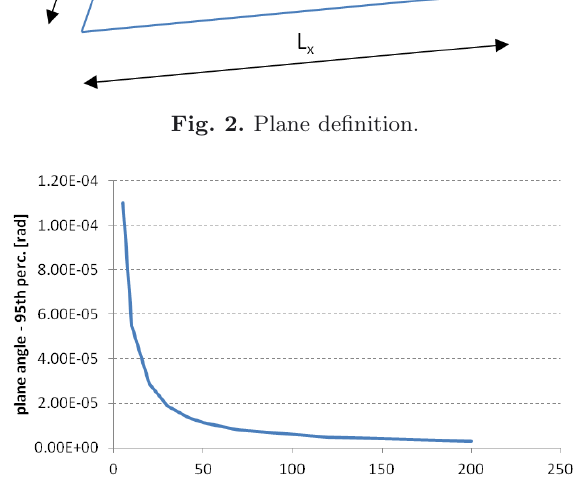
Fig. 3. Plane orientation